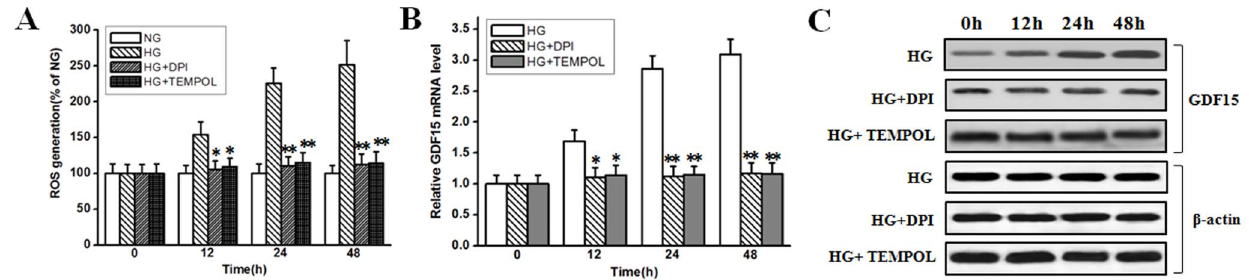
Figure 2. ROS inhibitors abolished high glucose-induced GDF15 expression. HUVEC cells were treated with normal (5.5 mmol/l) or high (33.3 mmol/l) glucose in the absence or presence of 10 m mol/l DPI or 1 mmol/l TEMPOL. A, ROS production were assayed as described in the materials and methods. B, C, at indicated time points, GDF15 mRNA and protein expression were detected by RT-PCR and western blot. NG, normal glucose. HG, high glucose. *, P , 0.05, **, P , 0.01 versus HG.